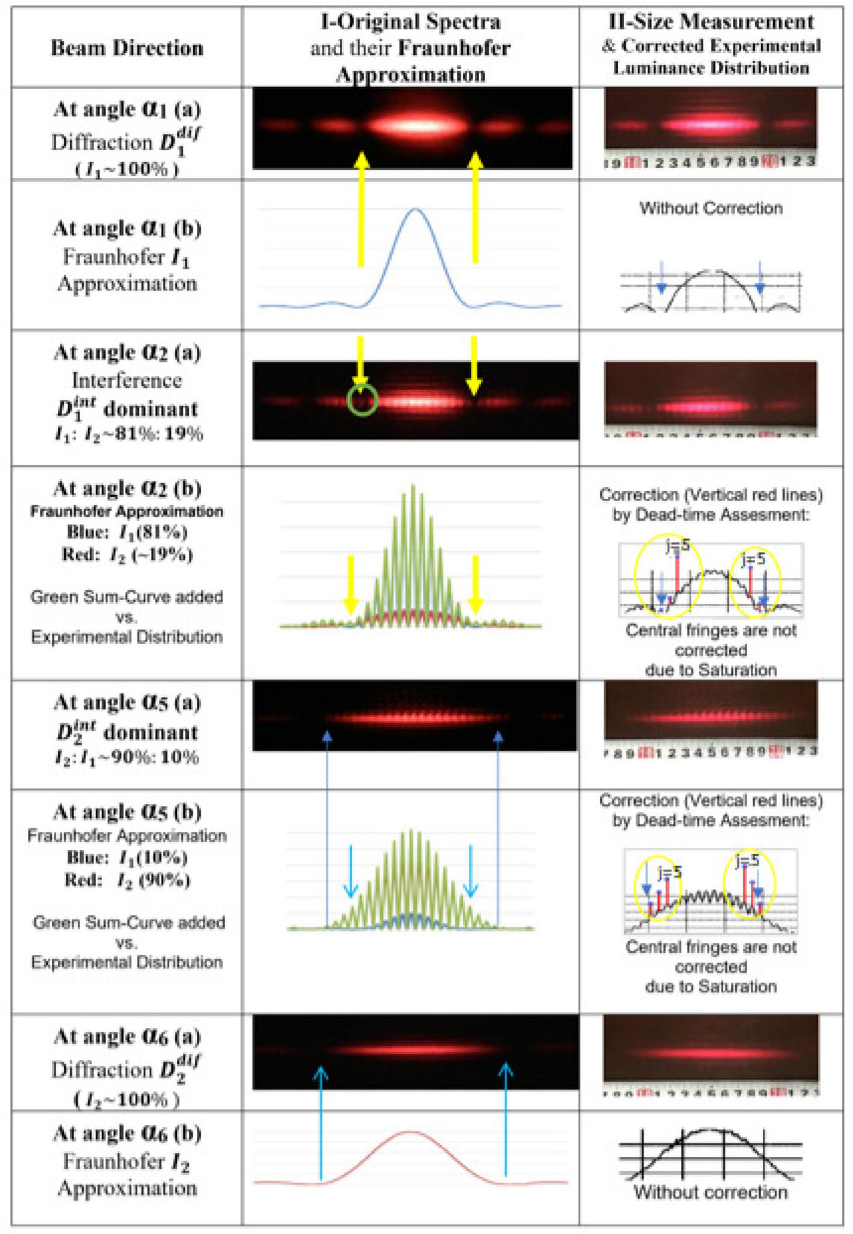
Figure 1. ”Which-way” identification by sizes of the central bands D int m : Shorter spectrum regards I 1 -photons passing through the wide-slit. I 1 -photons are absent in the first main minima (indicated by yellow arrows) of D dif 1 at α 1 . Contributions I 1 and I 2 are integrated between their corresponding main minima at x i arrows). Experimental luminance distributions in Column (II) for directions at α 2 and α 5 after correction of 5 7 (red lines in yellow ellipses) fit well the Fraunhofer approximation in the interference fringes with j = ÷ vicinity of the main